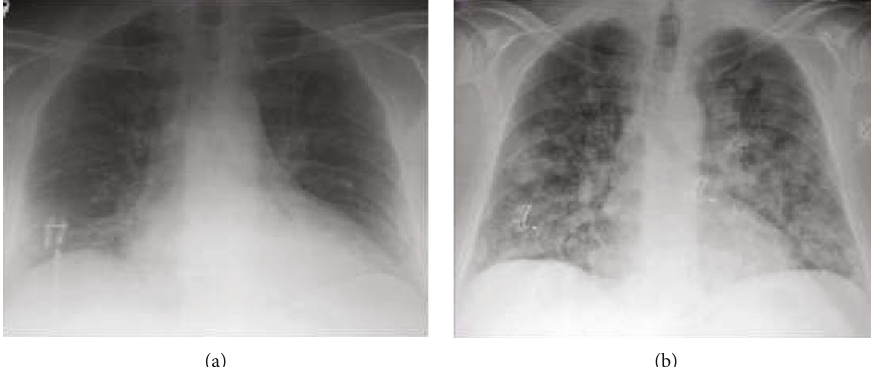
Figure 1: (a) Approximately 24 hours prior to the development of di ff use pulmonary hemorrhage. (b) After the development of severe cough and hemoptysis which required airway protection through